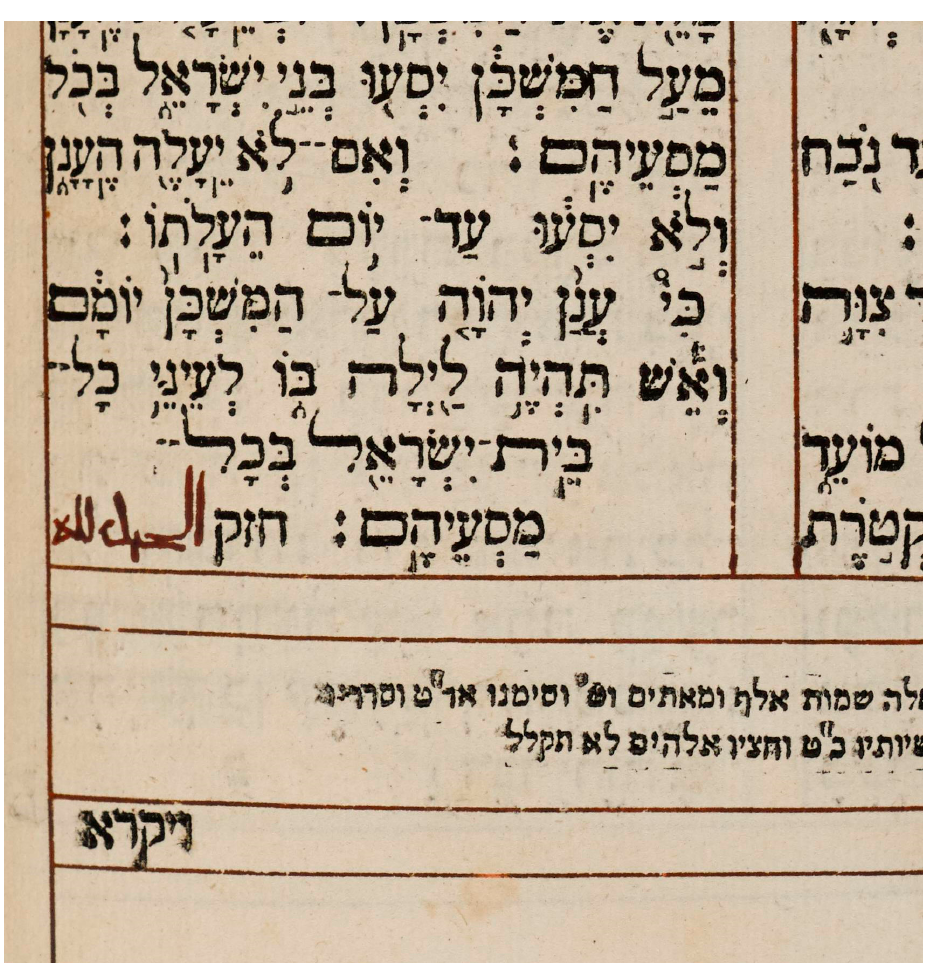
Figure 5. Detail of Tanakh (Hebrew Bible), with Arabic annotation; Marsh’s Library B.3.3.13.